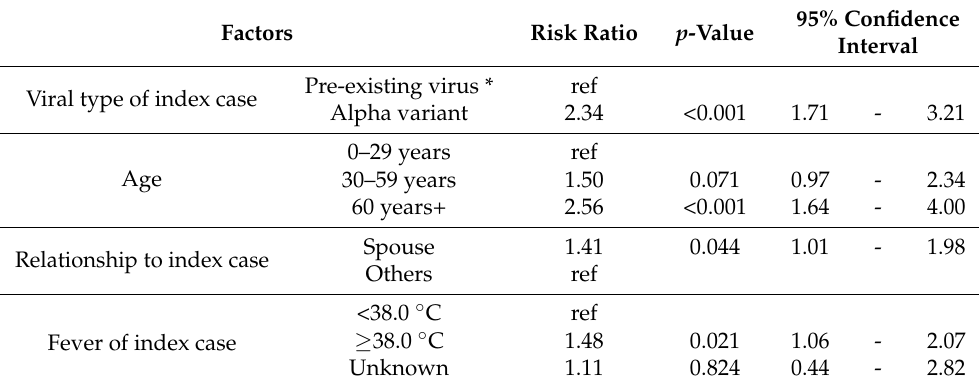
Table 3. Factors associated with the secondary attack rate of SARS-CoV-2 for Japanese household contacts focusing on viral type using multivariable Poisson regression